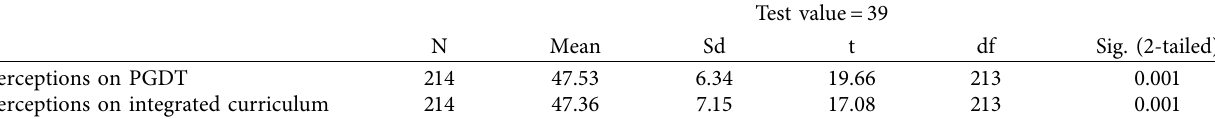
Table 2: One-sample t-test result of students’